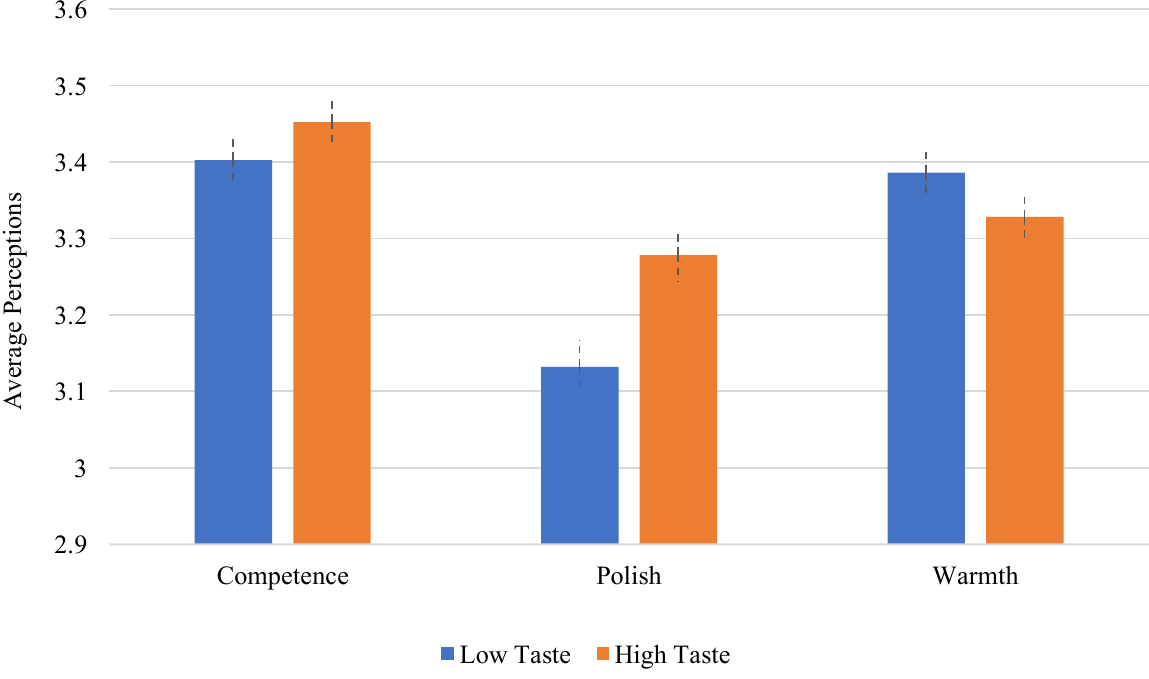
Figure 4: Effect of signals of cultural taste on perceptions of competence, polish, and warmth. Dashed lines represent confidence